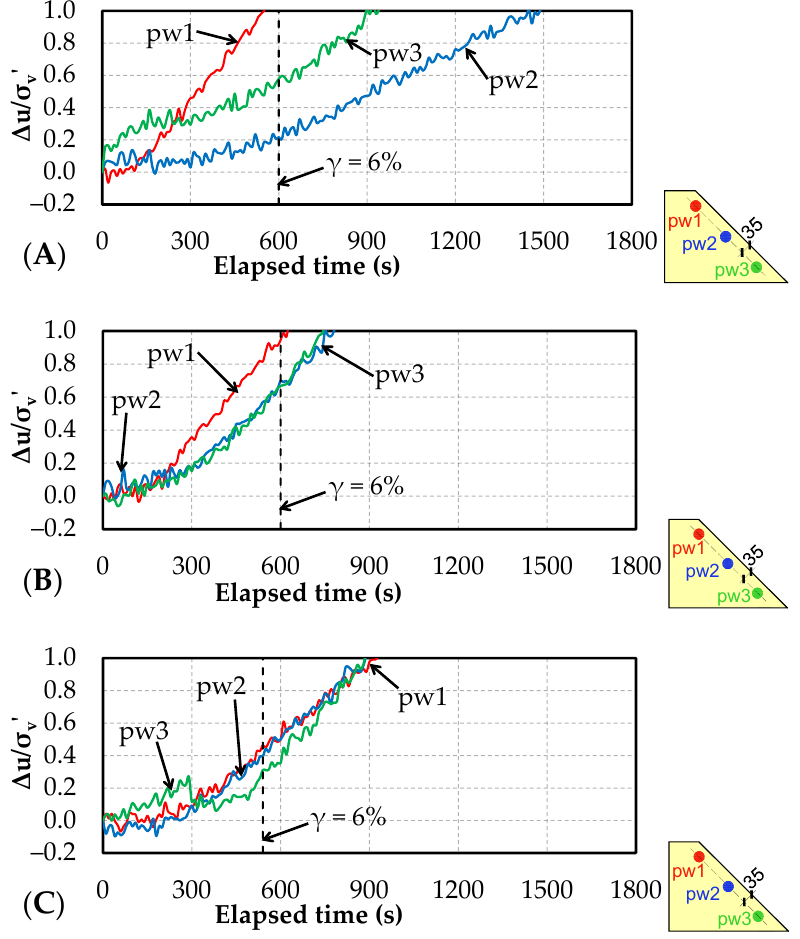
Figure 14. Change in pore water pressure during rainfall tests ( A ) K 8.5A, ( B ) K soil, ( C ) and K 40A . The increment of shear strain during rainfall is shown in Figure 15. When the shear strain was less than 6%, these relationships were almost linear for all three samples. Failure time for K 8.5A and K soil was 10 min and for K 40A was 9 min. Since the increase in pore water pressure during this period of K 40A was smaller, the faster failure rate of this soil sample is considered to be due to its smaller shear strength (internal friction angle). Thus, although an increase in fine content was shown to reduce soil permeability, it had almost no effect on rain-induced slope failure when the shear strain is less than 6%. After the shear strain exceeded 6%, it sharply increased at 27 min for the K 8.5A embankment along with secondary failure, which was not observed for K soil and K 40A during 30 min of rainfall. Even in another experiment when the precipitation time was increased to more than 1 h, secondary failure did not occur with K 40A . This difference can be explained through the failure pattern of K 8.5A and K 40A shown in Figure 16. In the case of K 8.5A , along with the increment of pore water pressure, the flow deformation that occurred at the base of the embankment led to the fast development of a larger slip line. However, the other parts in the model slope except for the slip line showed almost no change. In contrast, the K 40A embankment did not show slip line or gully erosion, but a small local failure appeared on the entire slope surface leading to a gradual reduction in size. Even when the pore water pressure exceeded 1, the flow deformation did not occur. The surface failure for K 40A can